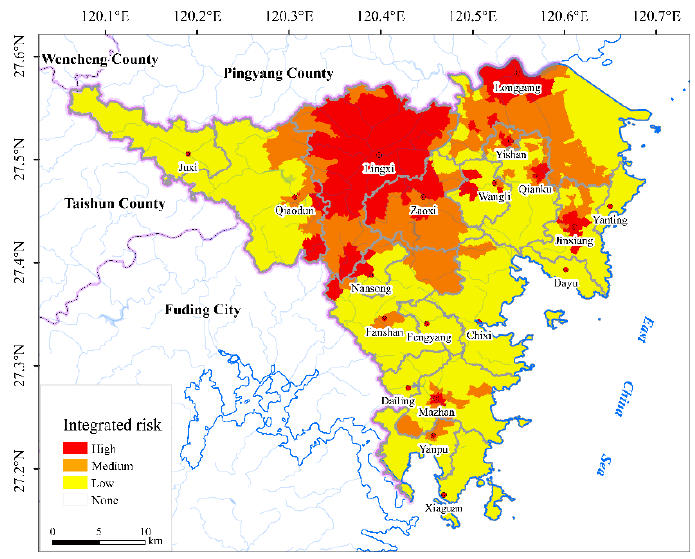
Figure 10. Spatial pattern of comprehensive multi-hazard risk in Cangnan